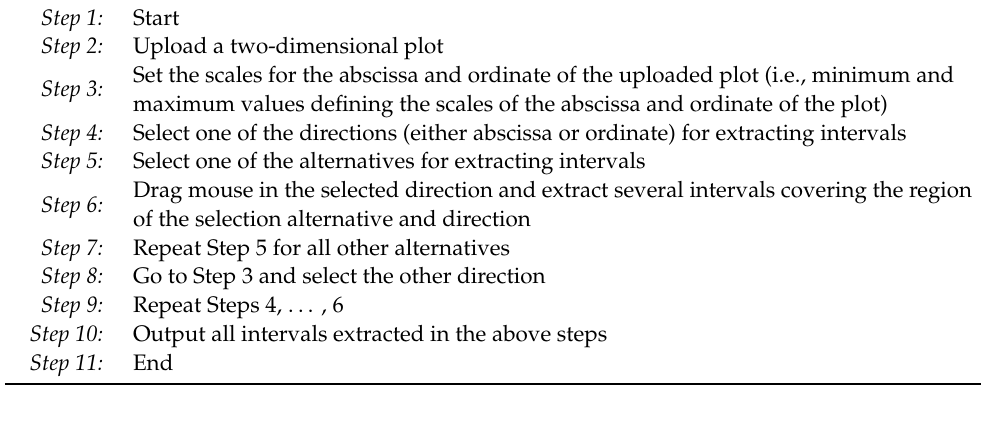
Algorithm 1: Decision-making computation.